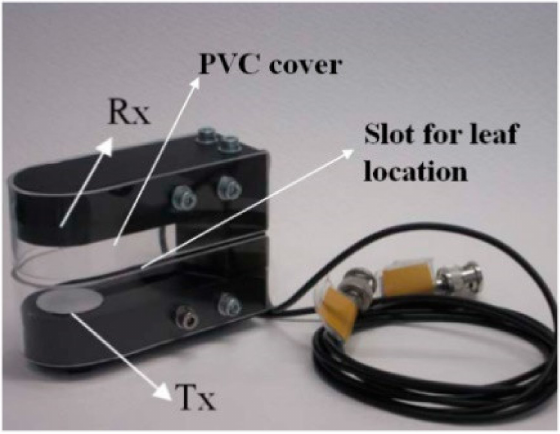
Figure 8. Air-coupled broadband ultrasonic spectroscopy setup